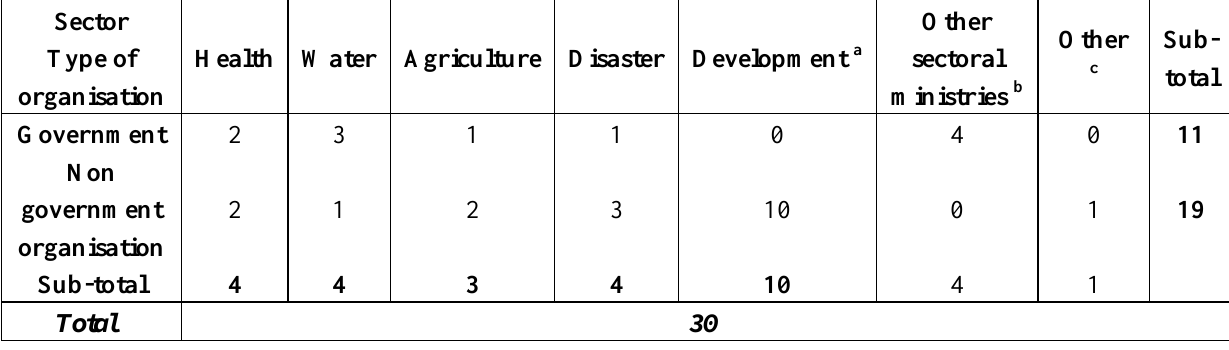
Table 1. Stakeholders who responded to social network questions stratified by sector and